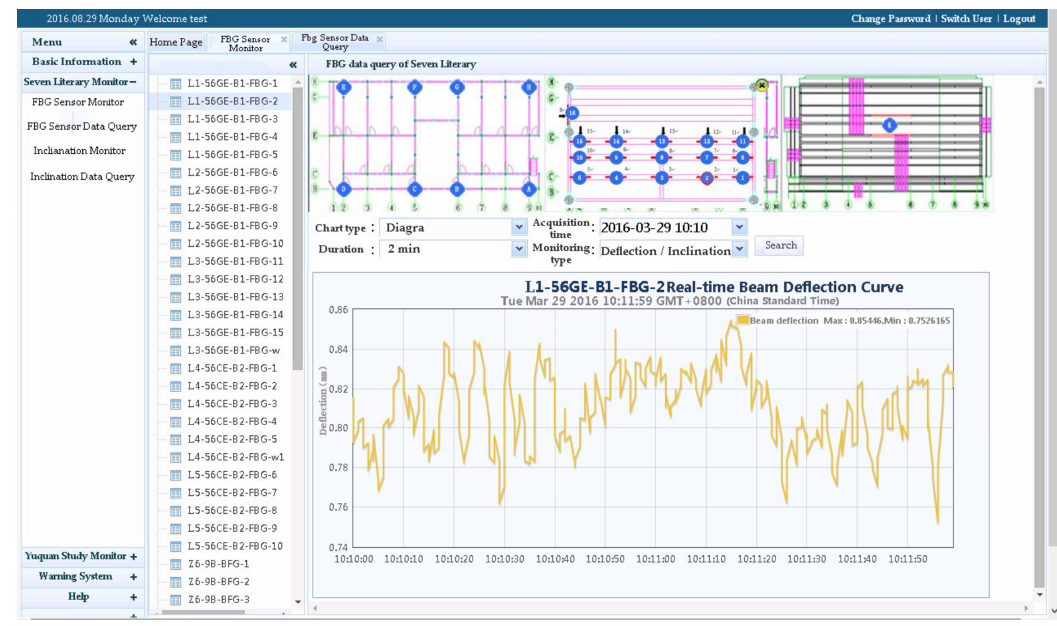
Figure 8. Real-time field monitoring of the ancient buildings via Structural Safety Assessment System